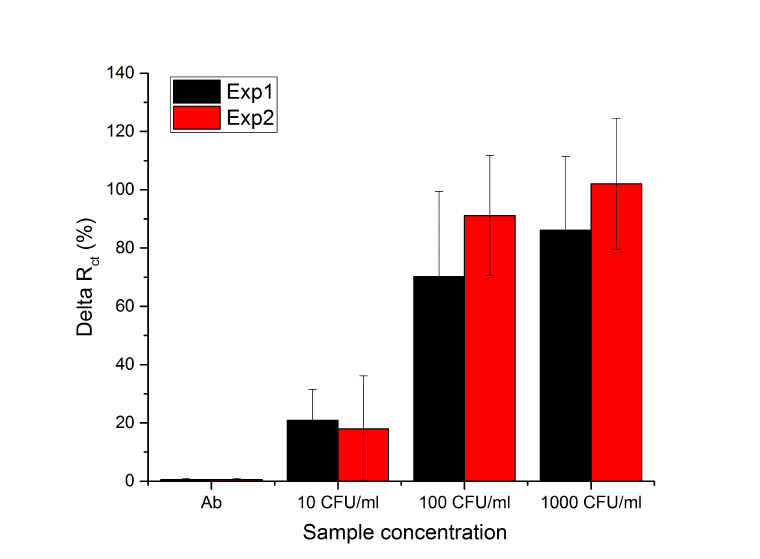
Figure 4. The bar graph of normalized charge transfer resistance ( DeltaR ct ) for each tested C. albicans concentration with 10, 100 and 100 CFU/mL. The data comes from two independent experiments in which data from at least 4 electrodes was recorded. The increase in R ct value is attributed to binding of C. albicans to the antibodies on the electrode